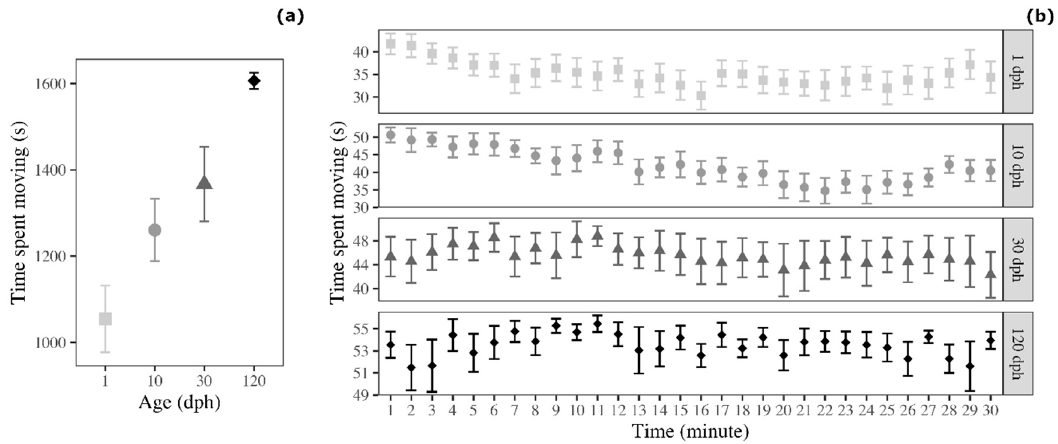
Figure 3. Time spent moving by medaka in the open-field test ( a ) as a function of age and ( b ) as a function of age and time (30 1 min time bins). Points represent means of the different age groups (squares = 1 dph, circles = 10 dph, triangles = 30 dph, and rhombuses = 120 dph) and error bars represent standard errors ( n = 16 per age-group).